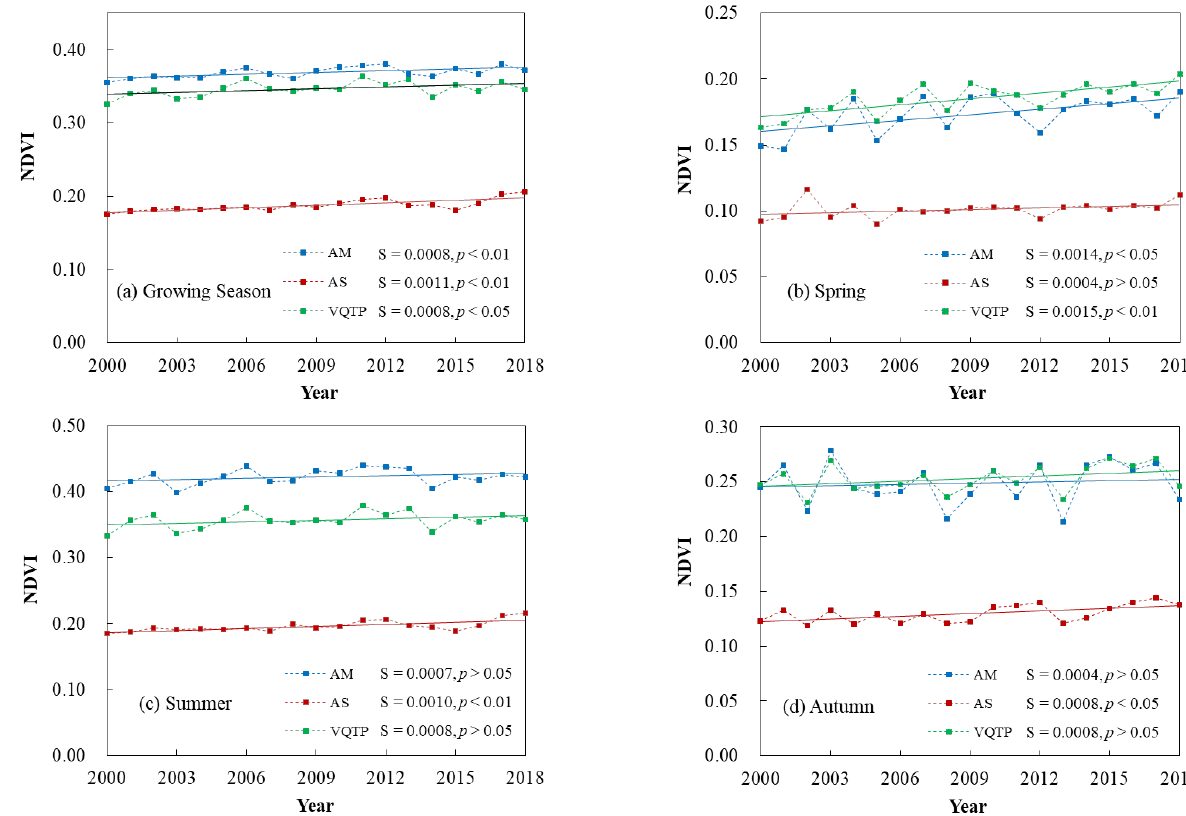
Figure 5. Interannual variation characteristics of the AM, AS and VQTP seasonal NDVI: ( a ) growing season, ( b ) spring, ( c ) summer, and ( d ) autumn. Table 1. Correlation coefficient and significance of the NDVI during different seasons for the AM, AS and VQTP from 2000 to 2018.